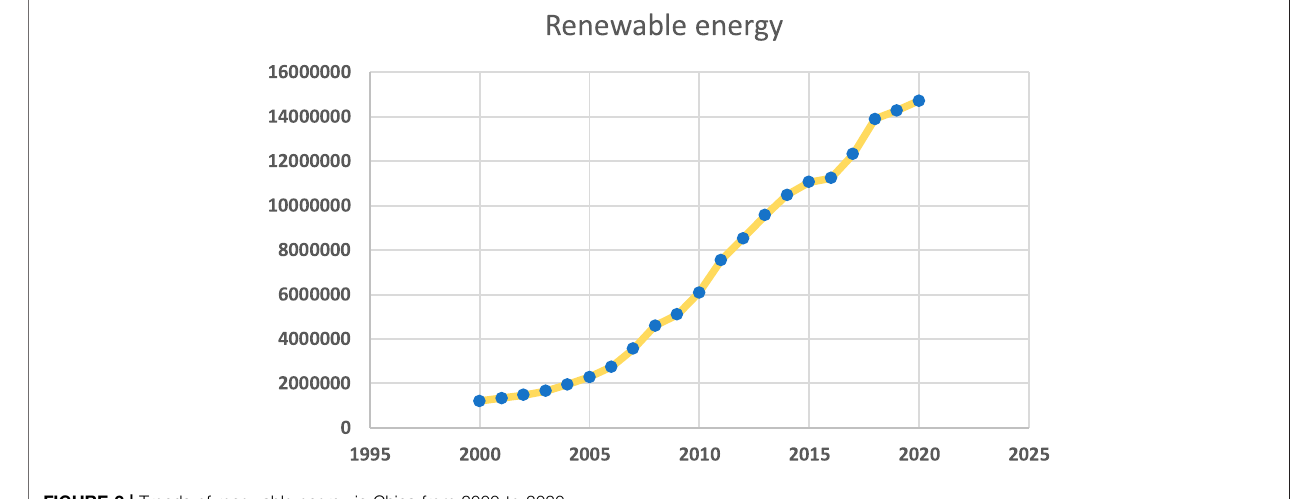
FIGURE 2 | Trends of renewable energy in China from 2000 to 2020.